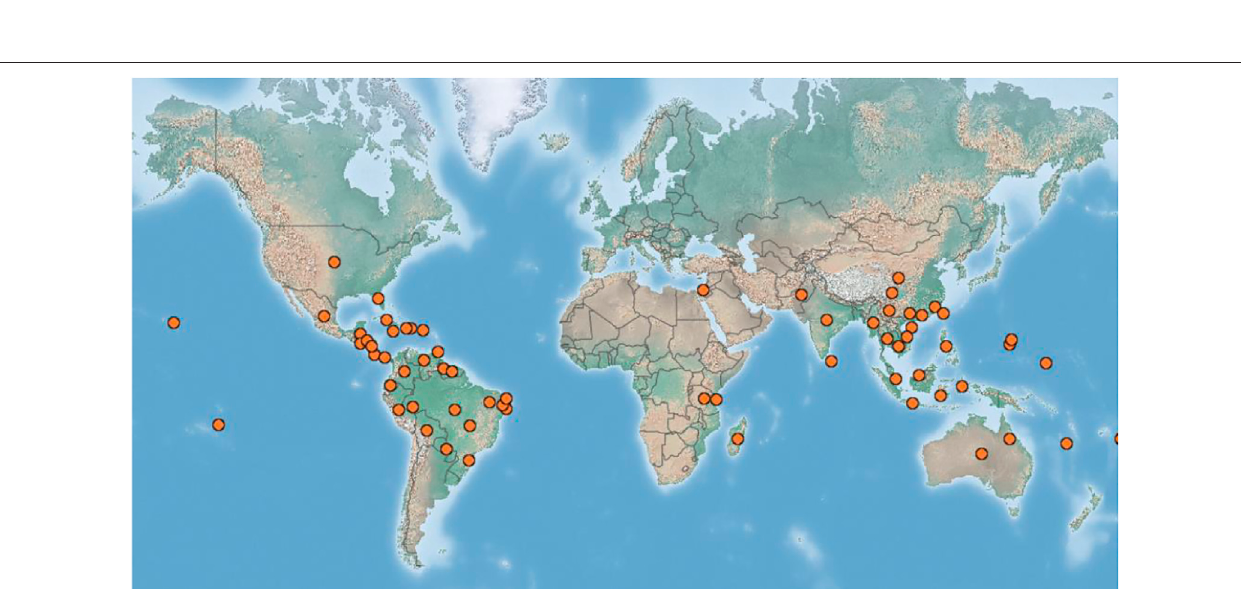
Frontiers in Pharmacology |